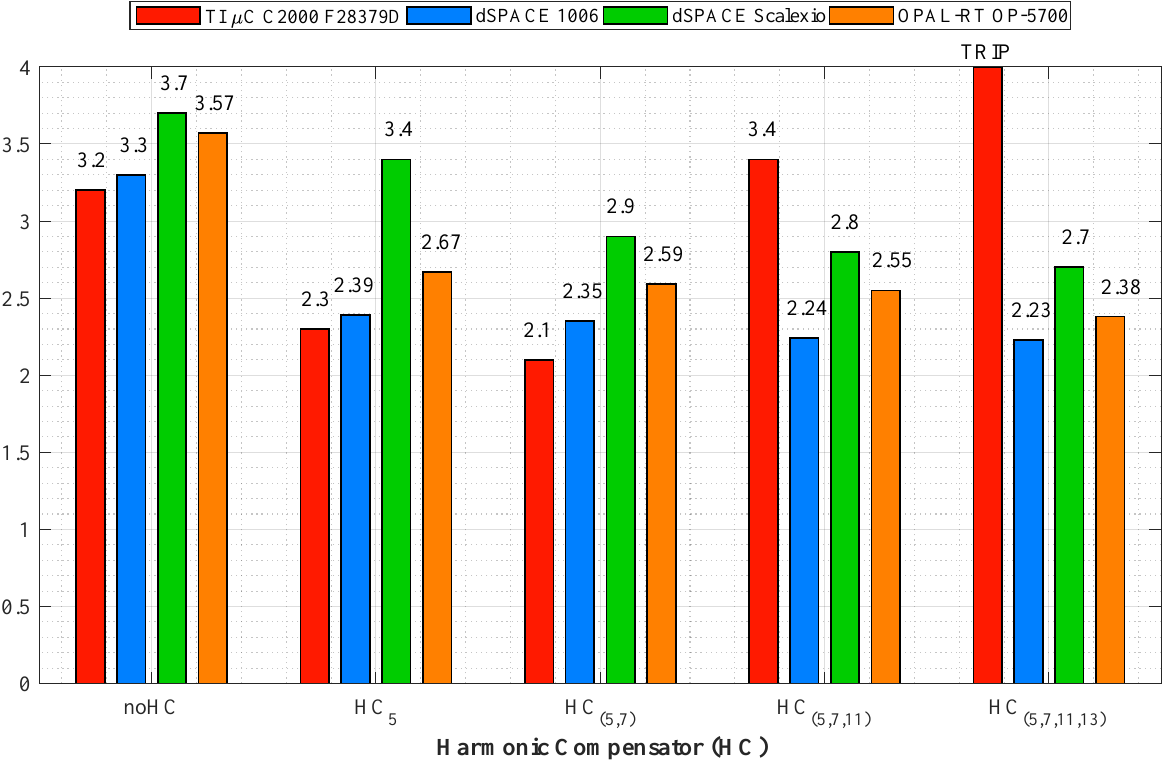
Figure 24. THD for each compensator added in each of the